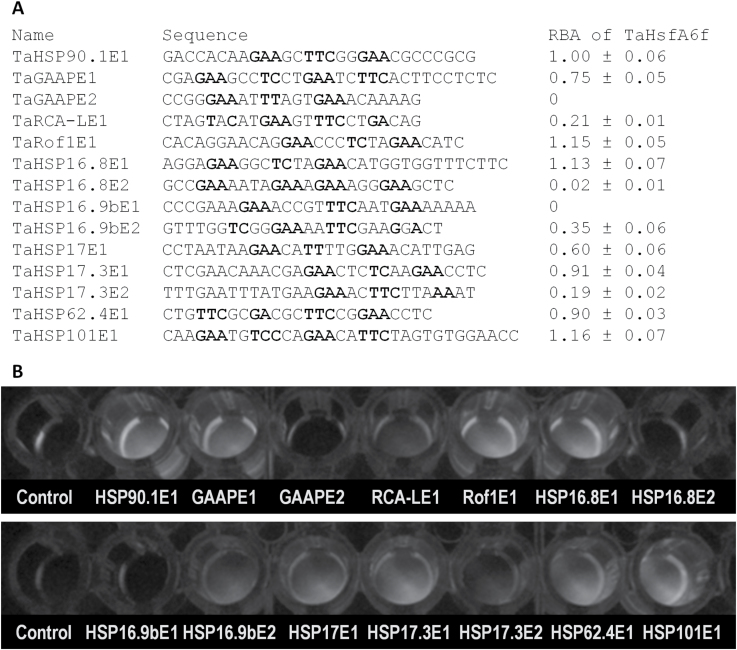
TaHsfA6f binding to HSE-like sequences in the promoters of genes regulated by TaHsfA6f. (A) Relative binding activity (RBA) of TaHsfA6f–CELD fusion protein to HSE-like sequences using CELD reporter-based DNA-binding assays. Values are means±SD of three assays and are relative to the binding activity of TaHSP90.1E1 from the TaHSP90.1-A1 promoter, which is arbitrarily set as 1. Putative HSE sequences were selected from the available promoter sequences within 1.5kb upstream of the translation start of these genes. GAA or TTC sequences are in bold. The positions of these HSE and HSE-like elements in their respective promoters are indicated in Supplementary Fig. S1. (B) Image of a representative set of assays for TaHsfA6f binding activity. Binding activity was quantified by measuring the fluorescence of the 4-methylumbelliferyl group produced through hydrolysis of 4-methylumbelliferyl-β-d-cellobioside by TaHsfA6f–CELD, which was bound to HSE-containing oligonucleotides immobilized in wells. The control is an oligonucleotide without a HSE.